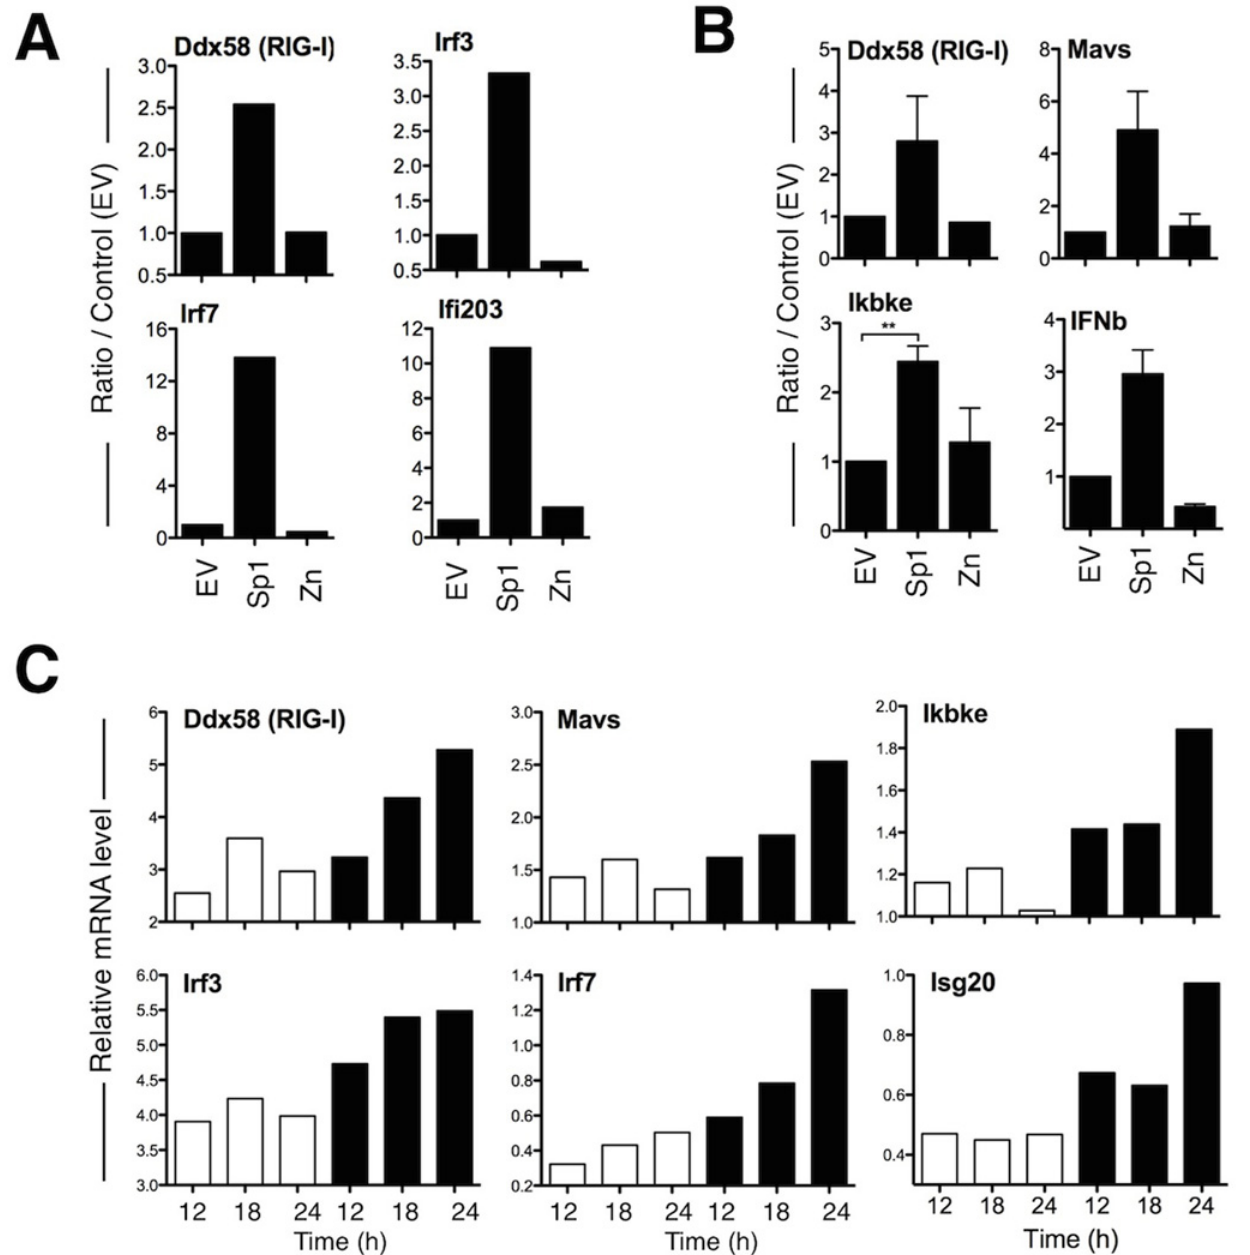
Fig 2. Sp1 overexpression activates genes of the RIG-I pathway. (A-B) BaF3 (A) and 3T3 (B) cells were transduced with retroviruses encoding wild-type Sp1, Sp1 Zn 2,3 mutant (Zn) that does not bind DNA, or empty vector (EV). Transduced cells (CD2 positive) were purified by magnetic selection 30 h (BaF3) or 72 h (3T3) later, and mRNA levels of indicated genes were measured by RT-qPCR (TLDA used in B) and normalized to housekeeping genes (HPRT in A and Rps-21 in B) mRNA levels. Data are representative of one out of three independent experiments in A. In B panel, data are representative of two independent experiments and statistical analysis was performed using 2-tailed t tests. Levels of significance are expressed as follows: ** P < 0.01. (C) BaF3-Sp1 inducible cell line was grown with (white bars) or without (black bars) dox for indicated times, and relative mRNA levels of indicated genes were quantified by RT-qPCR (TLDA). Data are representative of one out of four independent